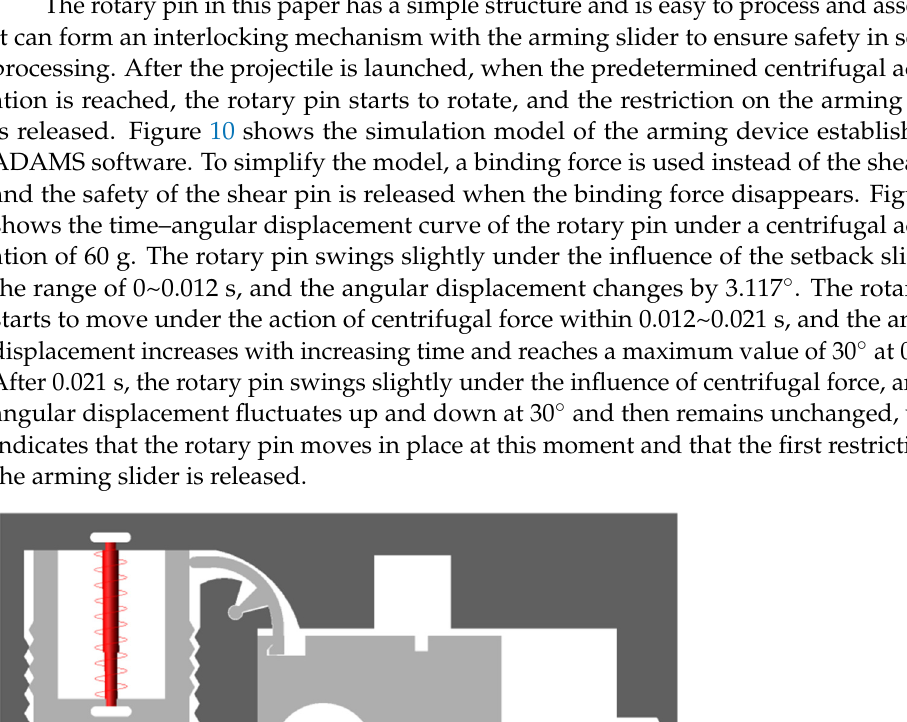
Figure 11. Time–angular displacement curve of the rotary pin. 3.3. Design and Simulation of the Locking Mechanism The locking mechanism consists of a head latch and a cassette latch, and its success of locking depends on the shape and strength of the head latch and the cassette latch. The head latch and cassette latch designed in this paper are in the form of zigzags, which can be locked by dislocation movement between the two during launching. Figure 12 shows the time–displacement curve of the head latch under a centrifugal acceleration of 60 g obtained by ADAMS software. The shear pin is fully released as the initial moment. The displacement of the head latch increases with increasing time and reaches a maximum value of 2.324 mm at 0.016 s. Then, the displacement decreases by 0.121 mm and remains unchanged after 0.018 s, indicating that the head latch has moved in place under the action of centrifugal force. It can also be seen from Figure 12 that there is no multiple rebound phenomenon after the collision between the head latch and the cassette latch, and it is possible to realize one-time reliable locking. Therefore, it is not necessary to increase the reliability of locking by setting a microspring in the design. Figure 13 shows the position of the rotary pin and locking state after 0.018 s. When the rotary pin moves to the position of releasing the safety, the head latch completely enters the cassette latch and grips two teeth, and the locking mechanism is successfully locked, indicating that the shape design of the rotary pin, the head latch, and the cassette latch is reasonable.